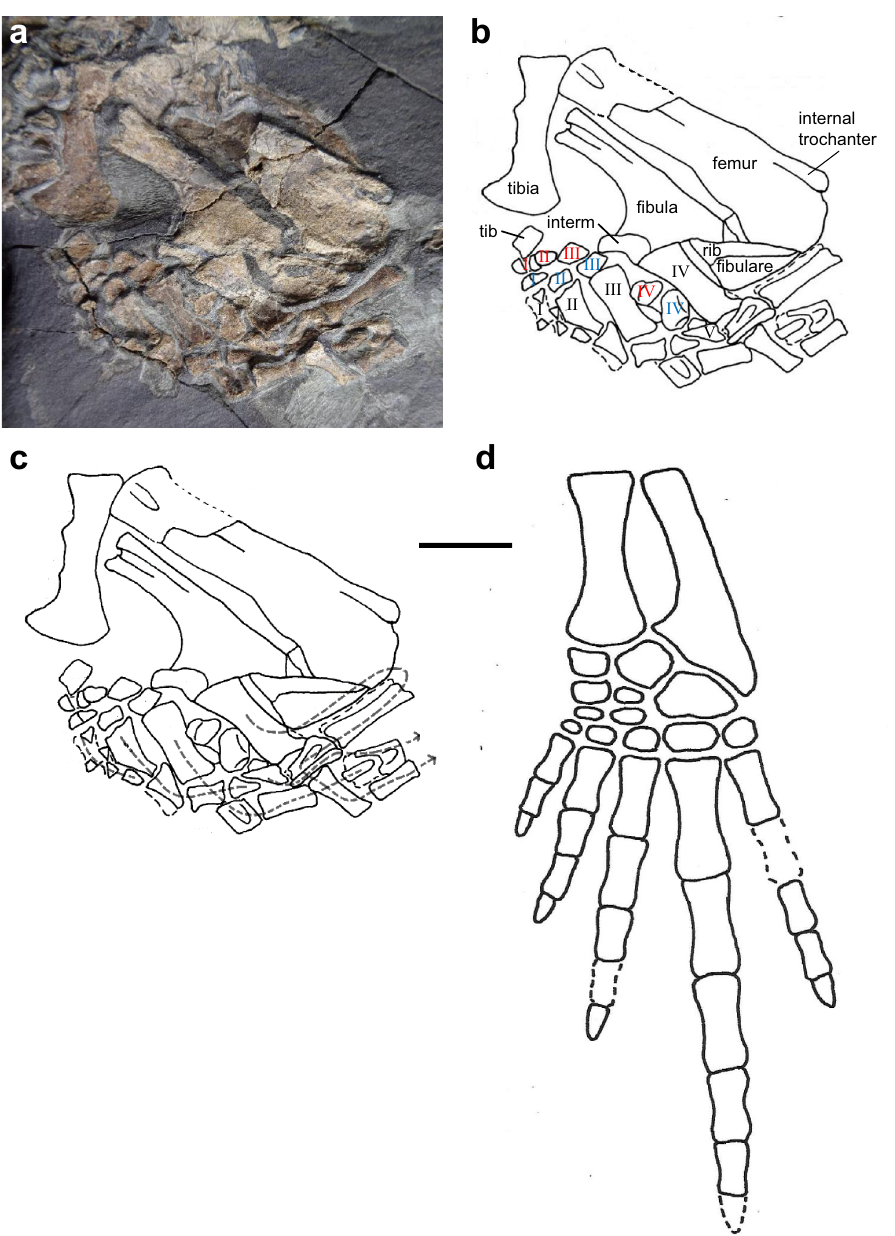
Fig. 2 Termonerpeton makrydactylus gen. et sp. nov. left hindlimb of UMZC 2019.1. a Specimen photograph, showing close-up view of hindlimb skeleton, b Interpretive drawing, with centralia, distal tarsals, and metatarsals indicated by red, blue, and black Roman numerals, respectively, c Interpretive drawing with dashed lines connecting elements of individual digits, d Reconstruction of left tibia, fi bula and pes. Scale bars 10 mm. Abbreviations: interm intermedium, tib